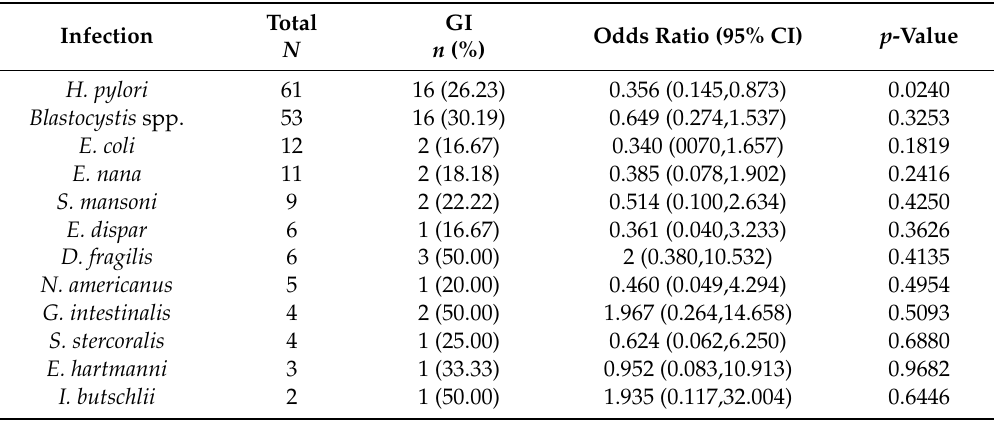
Table 4. Frequency of gastrointestinal (GI) symptoms by type of infection. H. pylori infection